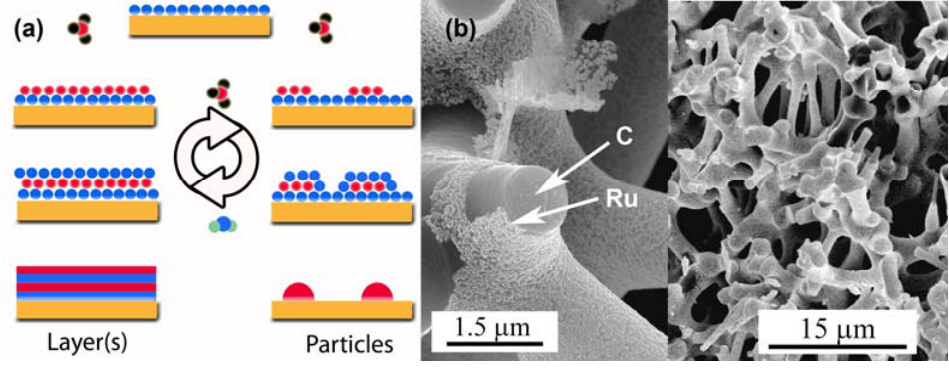
Figure 11. (a) ALD employs sequential, self-limiting surface reactions to overcome diffusion limitations. Both conformal films (left) and individual nanoparticles (right) can be grown, depending on the surface chemistry. (b) SEM micrographs of the fracture surface of a Ru-coated CA at different magnification levels. Carbon ligaments and the Ru nanoparticle film are indicated the arrows labeled “C” and “Ru”, respectively. Part (b) is reproduced from Ref.